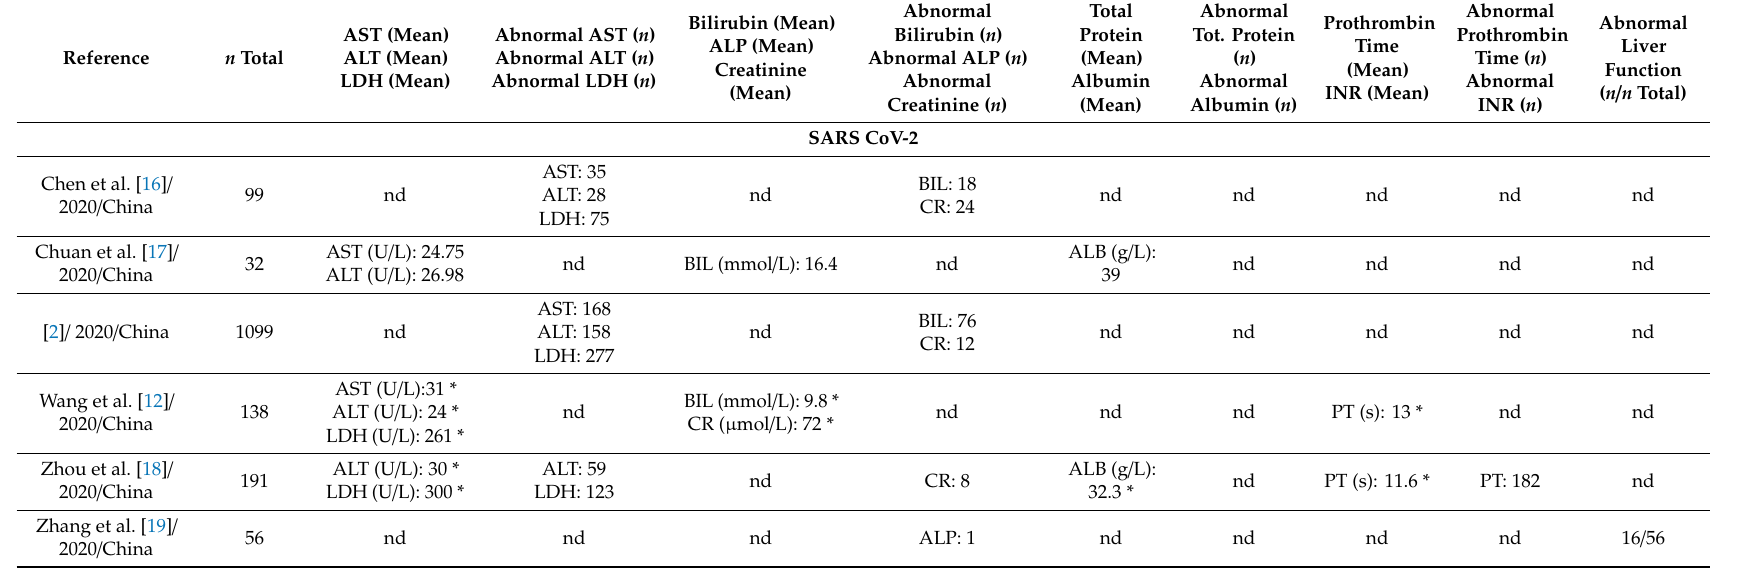
Table 2. Liver-related outcomes in presented